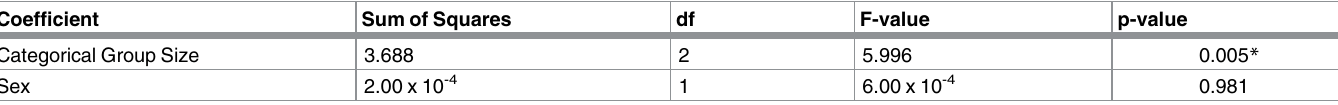
Table 1. Effect of categorical group size and sex on log transformed feather corticosterone (pg/mg) of adult Smooth-billed Anis ( Crotophaga ani ): Results of a linear mixed-effects model (n = 50). Coefficient Sum of Squares df F-value p-value Categorical Group Size 3.688 Sex 0.981 asterisk ( * ) indicates significance at an alpha of